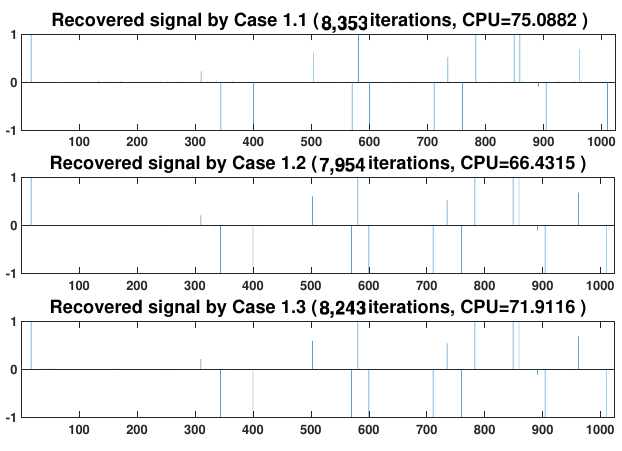
Figure 4. Recovered signal by Case 1.1, Case 1.2 and Case 1.3, respectively.